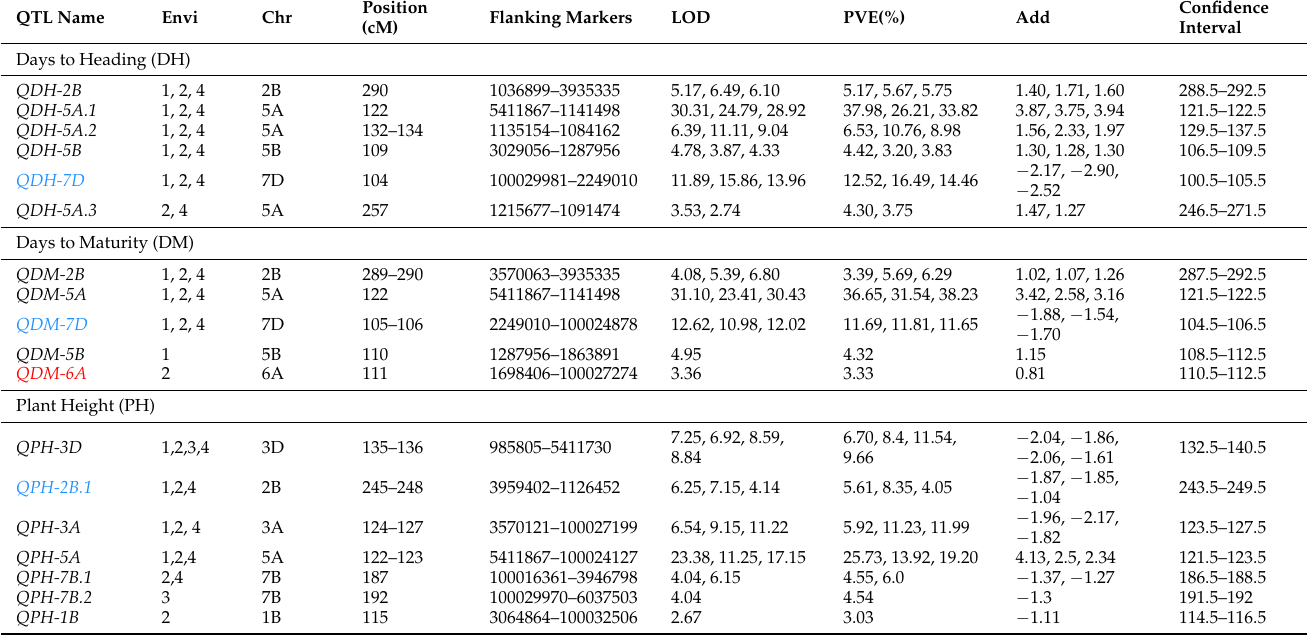
Table 4. QTLs identified for DH, DM, PH, TKW and TW for 2017–2018 (Y1), 2018–2019 (Y2), 2019–2020 (Y3) and across